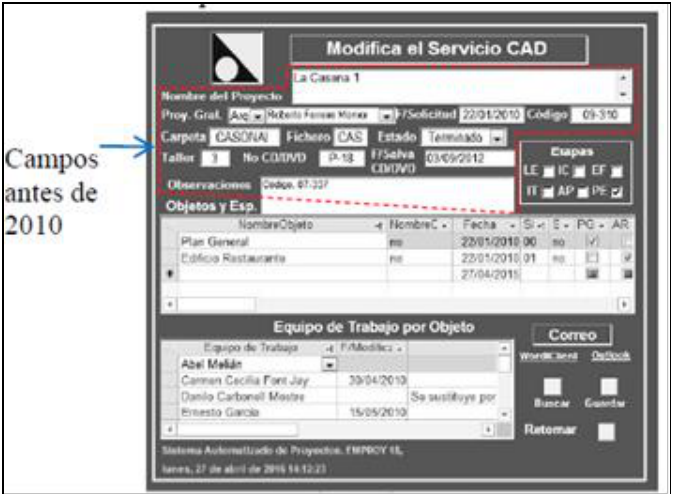
Figura 6: Modifica el Servicio CAD salvados a partir de 2010. Fuente: Autor, (2018).